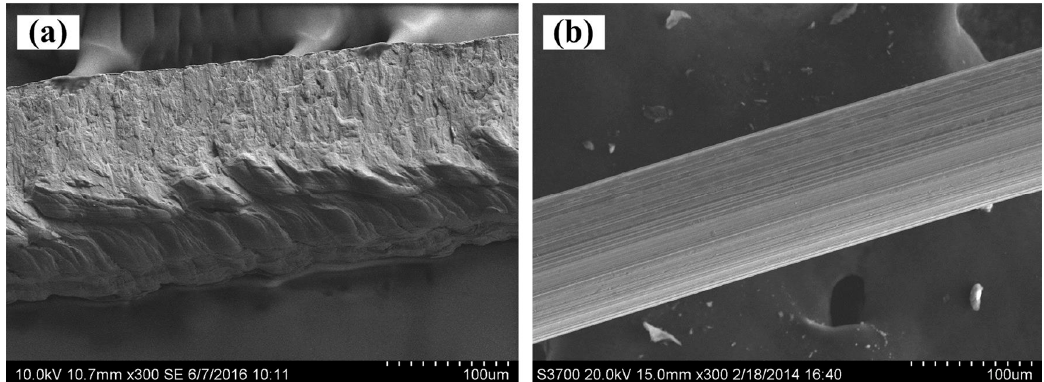
Figure 5. SEM of single cutting stainless steel fiber ( a ) and bundle-drawing fiber ( b ).